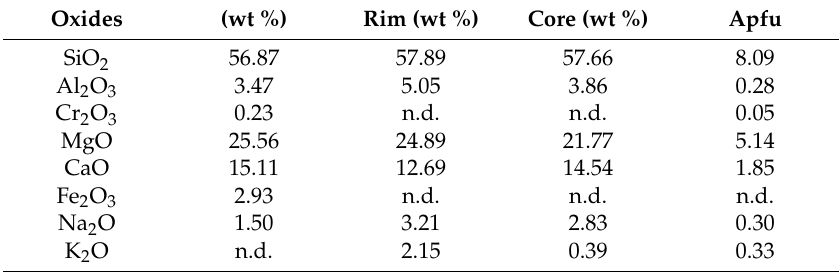
Table 3. Chemical composition obtained by SEM (15 analytical points) and variations compositions in the rim and core of fibrous tremolite.